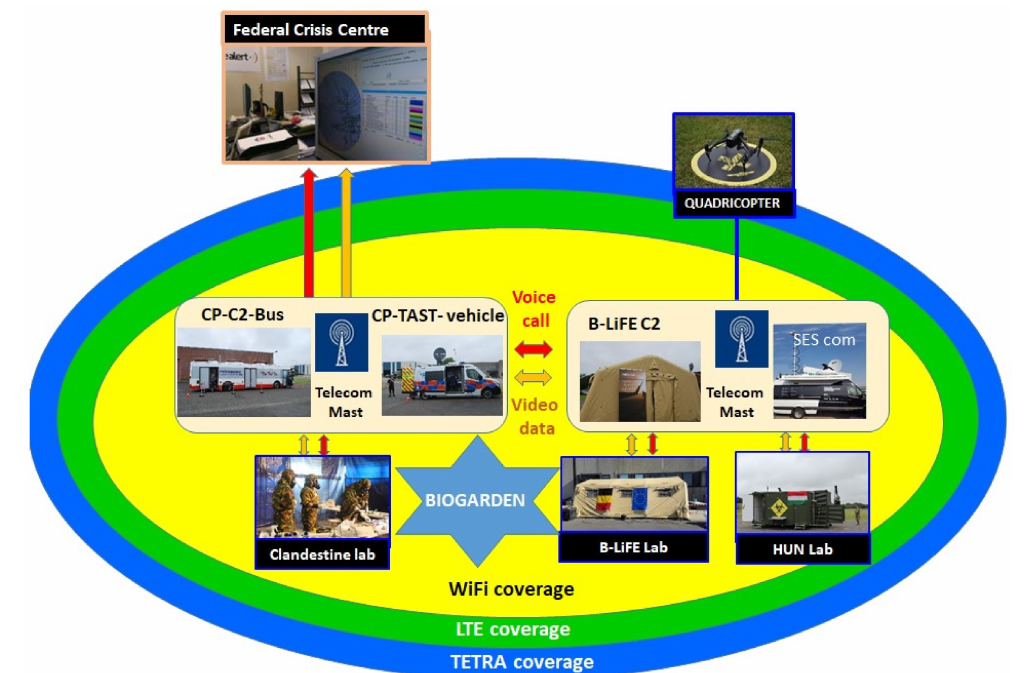
Figure 7. Bio-Garden exercise: Schematic representation of the Bio-Garden participants and telecommunication tools. The B-LiFE telecommunication team installed an omnidirectional antenna for TETRA and a directional antenna for LTE on fast-deployment antenna mast#1 (H = 3 m) near the B-LiFE telecommunication tent. Three-directional WiFi antennas (to provide better coverage) with the outdoor WiFi APs and the antenna for point-to-point (PtP) configuration were installed on antenna mast#2 (H = 3.5 m), and the counterpart was installed on fast- deployment telecom mast#3 (H = 3.5 m) near the Civil Protection TAST and C2 Bus